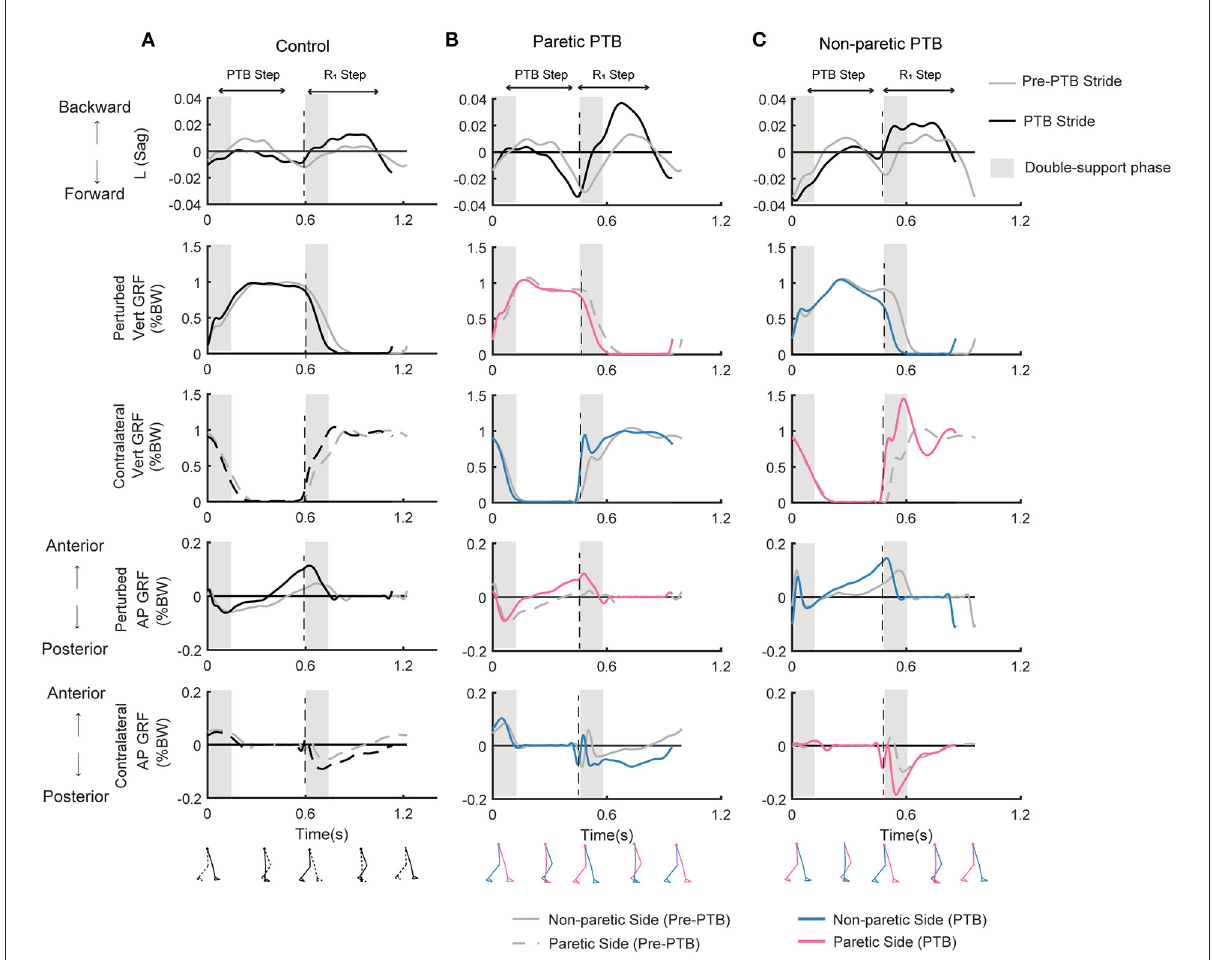
FIGURE3 Whole-body angular momentum in the sagittal plane and ground reaction forces for one representative neurotypical participant (A) and a stroke participant during a paretic perturbation (B) and non-paretic perturbation (C) for both a pre-perturbation stride and a perturbation stride. Each stride began at foot strike. The gray traces indicate the time series data for a pre-perturbation stride while the black or colored traces indicate a perturbation stride. Negative values of angular momentum represent forward rotation while positive values represent backward rotation. Ground reaction forces (% body weight) in the vertical and anterior-posterior directions for the perturbed and the contralateral limb when perturbations occurred on the dominant side for the neurotypical participant (A) , or on the paretic (B) or non-paretic sides (C) for the stroke participant. For the neurotypical participant, black lines indicated the perturbed side, and the dashed lines indicated the contralateral side. For the stroke participant, pink and blue lines represent the paretic leg and non-paretic leg, respectively. Black dashed vertical lines correspond to the time of foot strike. Gray shaded vertical box corresponds to the double support phase from the time of foot strike to the contralateral foot-off. Pre-PTB, pre-perturbation stride; PTB, perturbation